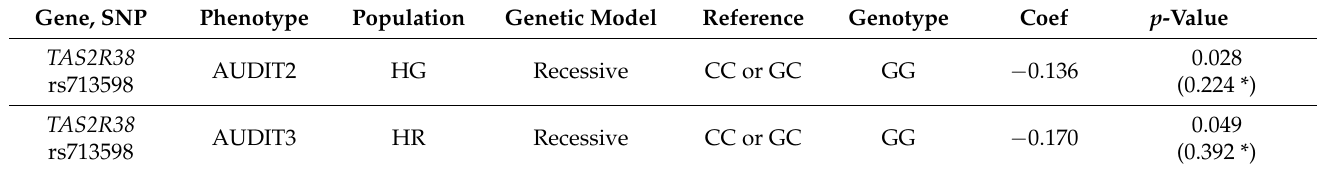
Table 3. Association of selected genetic polymorphisms with alcohol consumption behavior in the Hungarian general and Roma